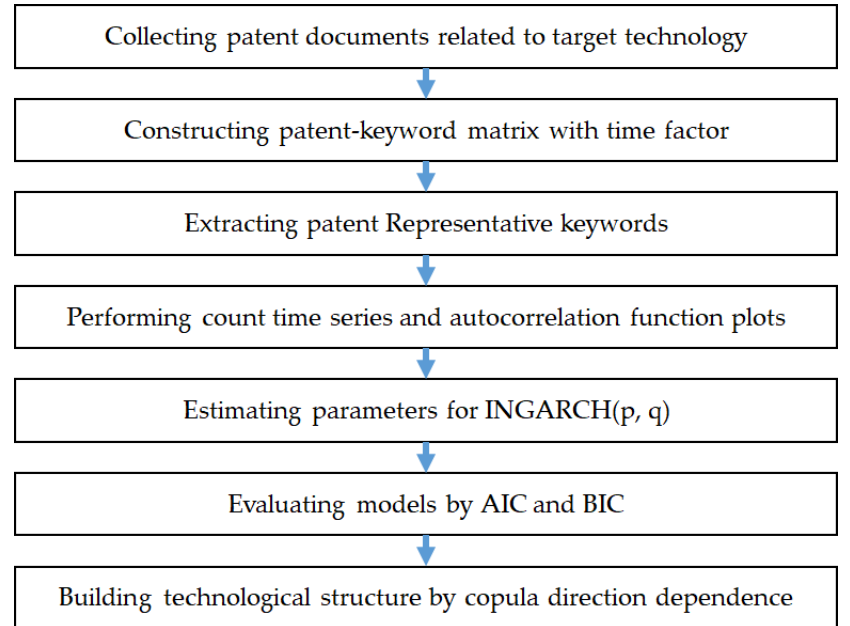
Figure 2. Patent keyword analysis process using the time series and copula models.